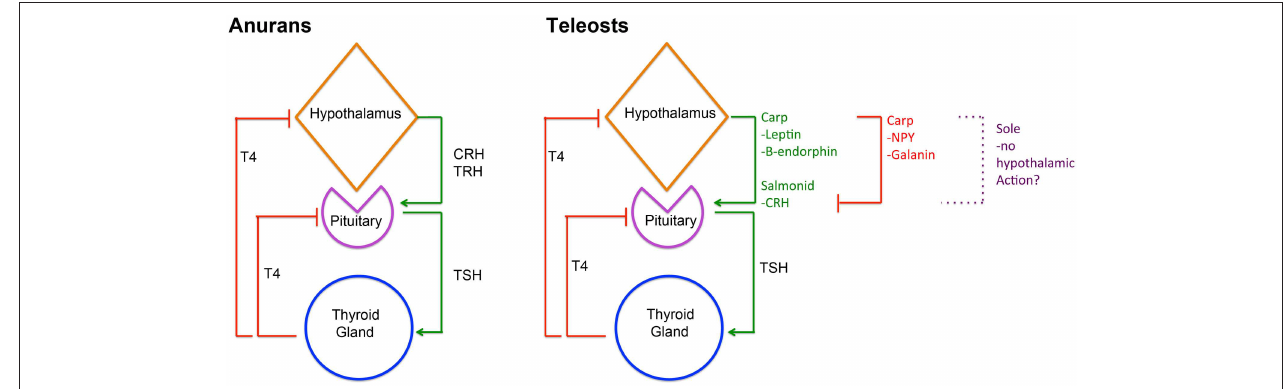
FIGURE 2 | Diagram depicting HPT-axis regulation in anurans and teleosts. In anurans, hypothalamic derived CRH and/or TRH are involved in regulating pituitary TSHb expression and secretion that in turn regulates T4 production in the thyroid gland and consequently serum levels. Inversely, serum T4 then negatively regulates CRH/TRH and TSHb expression and secretion. In teleosts, HPT-axis regulation is more diverse and likely reflects species specificity. In salmonids, CRH seems to regulate pituitary TSHb expression and secretion, whereas in carp leptin and β -endorphin seem to assume that role. Notably, in carp, Galanin, and NPY seem to repress TSHb expression and secretion. Remarkably, in sole metamorphosis, neither TRH nor CRH seems to be involved in regulating pituitary TSHb raising questions about the role of the hypothalamus in HPT-axis regulation in these teleosts. Despite this, in all teleosts studied so far, the negative feedback loop between thyroid gland T4 and pituitary TSHb is present and